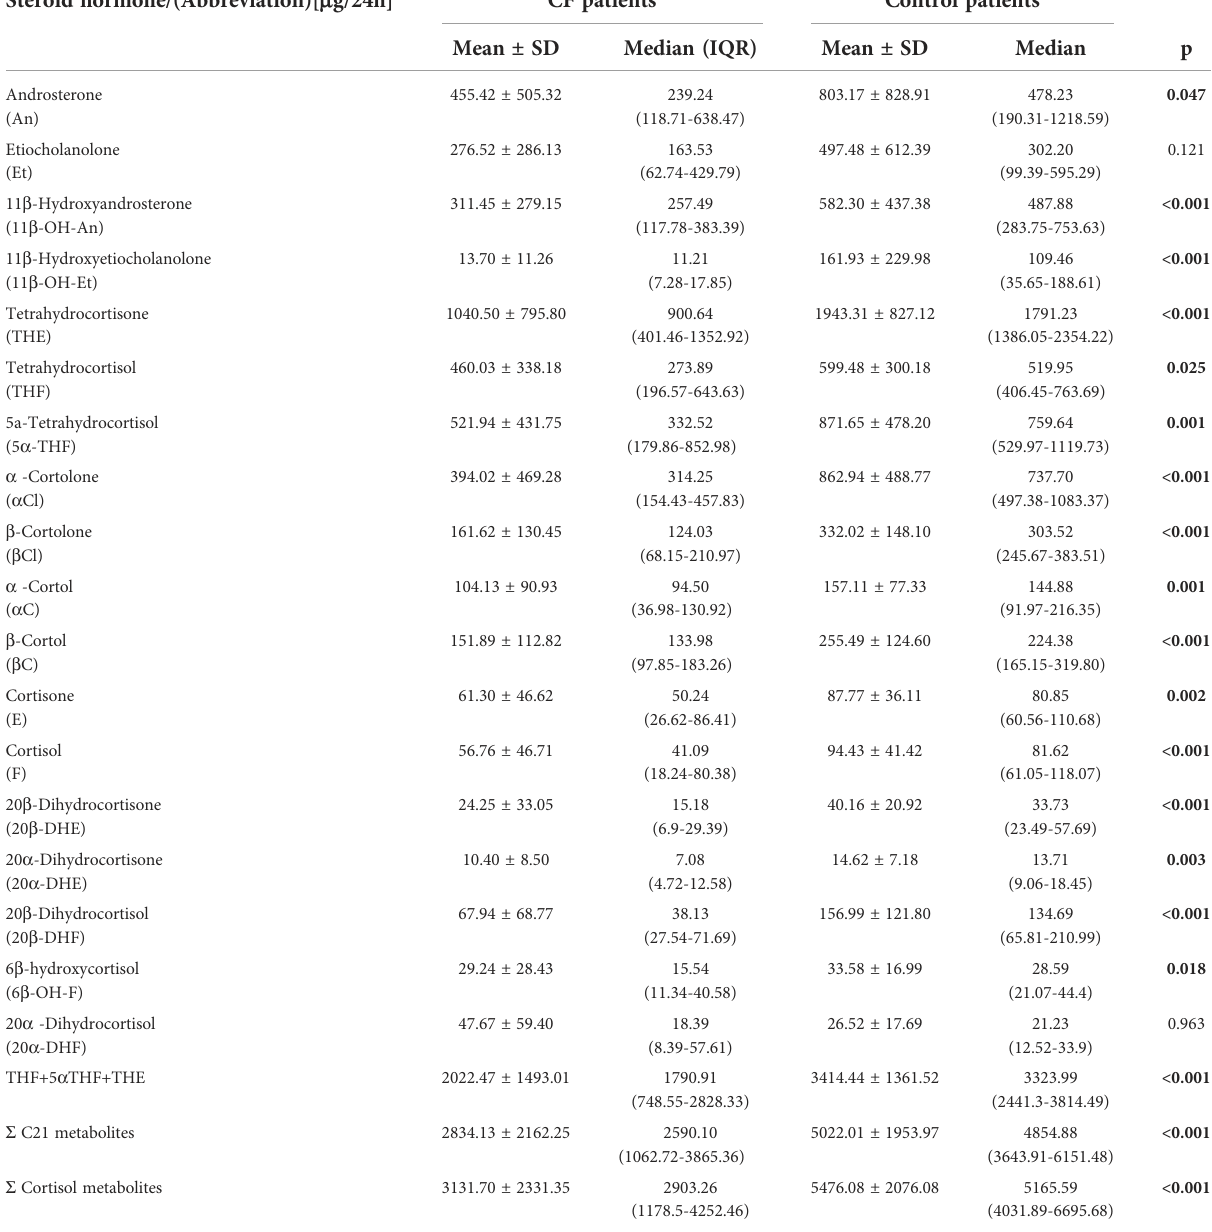
TABLE 2 Urinary 24-h excretion rates of steroid metabolites (body surface area corrected). Steroid hormone/(Abbreviation)[ m